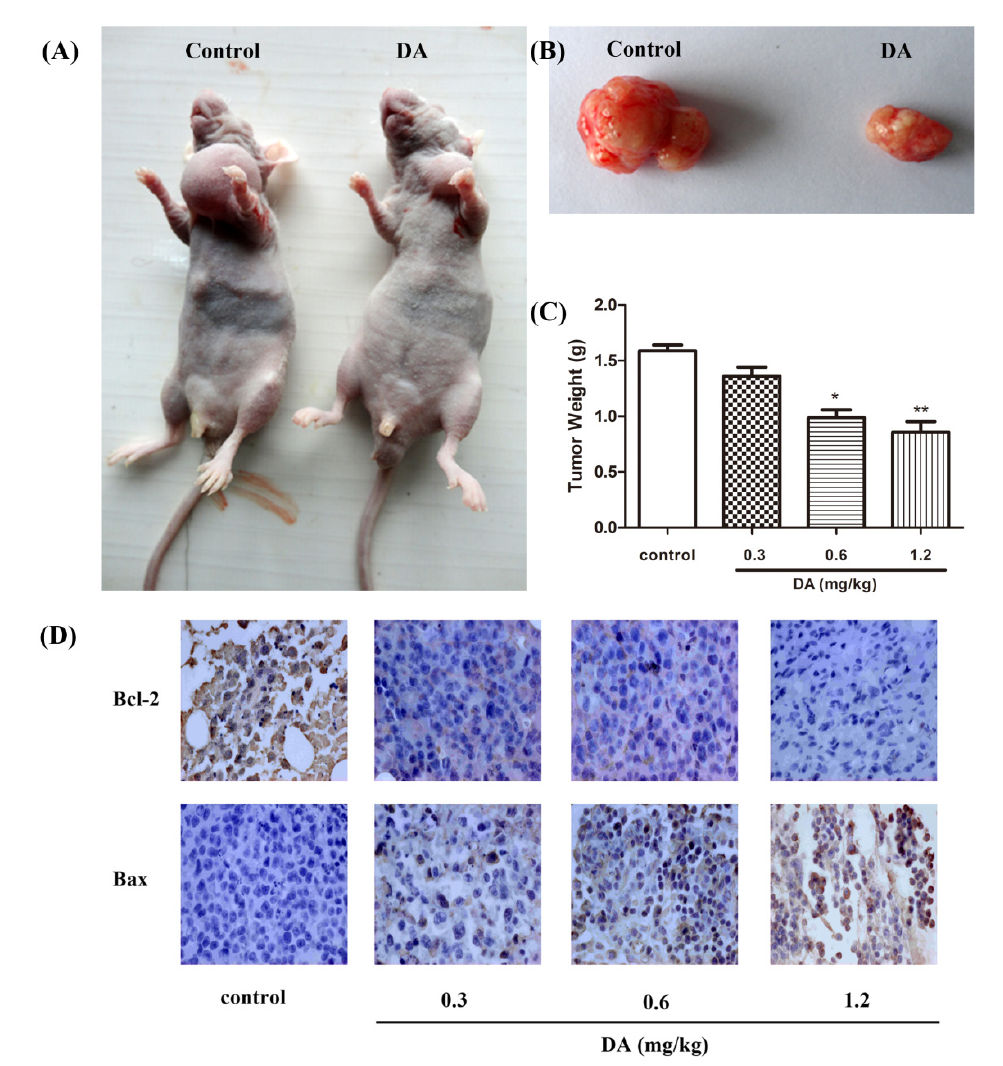
Figure 6. Effect of DA on tumor growth and the expression of Bcl-2 family in vivo . HCT-116 xenografts were generated by inoculating cells subcutaneously (s.c.) in nude mice. The control group was injected with an equal amount of saline, and the experimental group was injected with different doses of DA. ( A , B ) Photograph of the tumor in the control group and the DA-treated group. ( C ) Tumor weight at time of sacrifice for different treated groups. * p < 0.05 and ** p < 0.01, compared with the